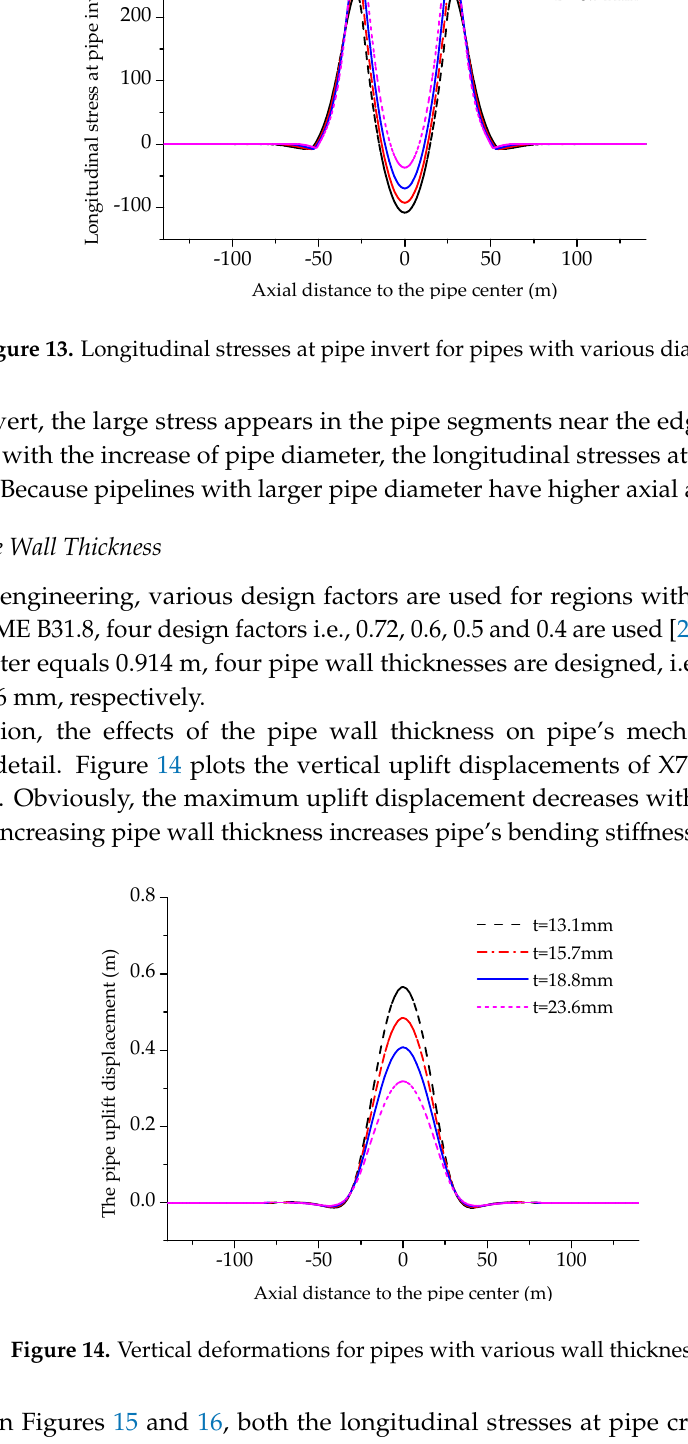
Figure 12. Longitudinal stresses at pipe crown for pipes with various diameters